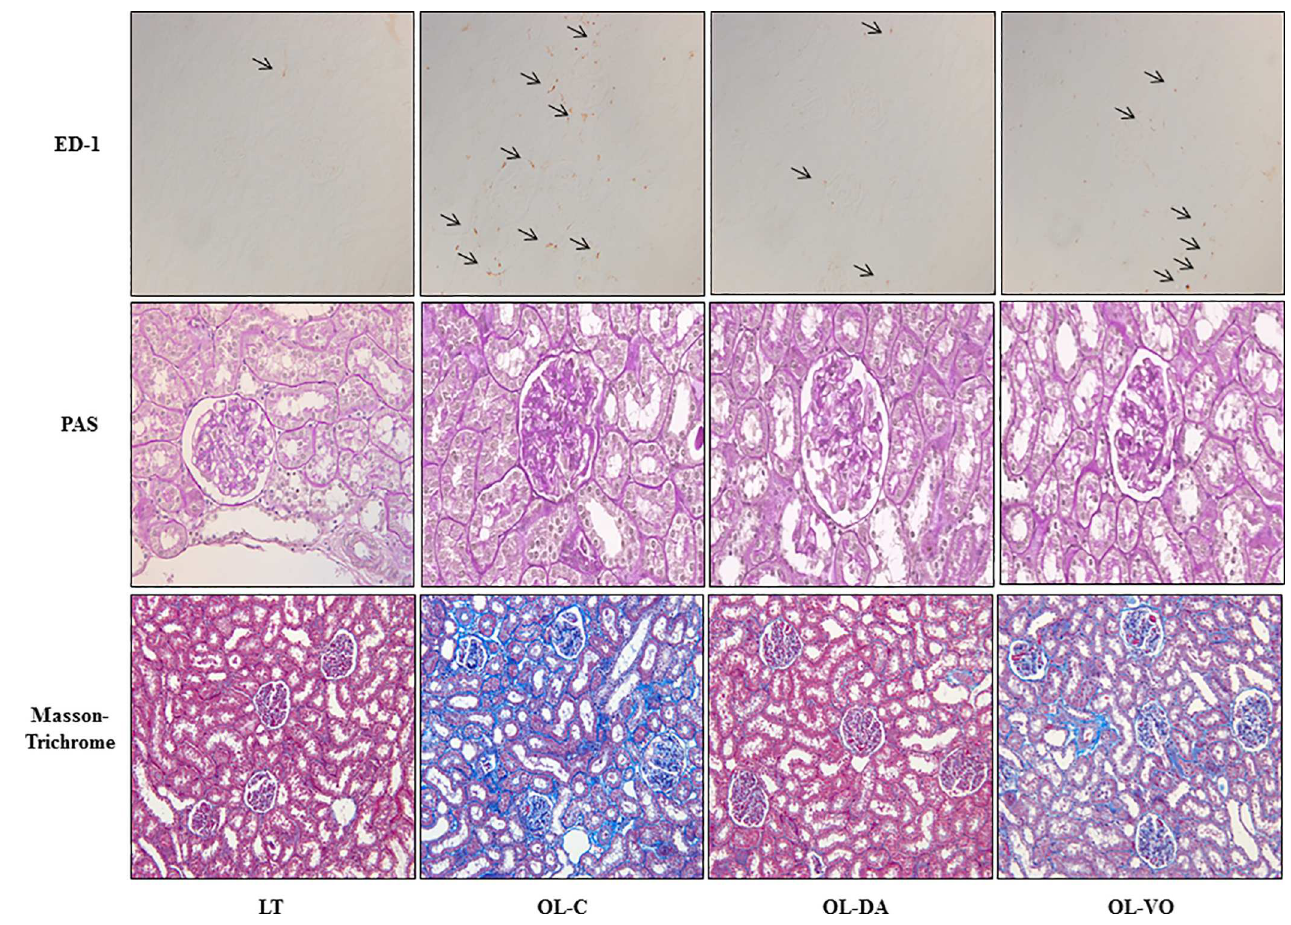
Fig 6. Changes in glomerular or tubulointerstitial phenotypes in LETO or OLETF rats. Representative sections for assessing the inflammatory cell infiltration (immunostaining for ED-1, x 200), glomerularexpansion(PAS, x 400) and tubulointerstitial fibrosis (Masson trichrome, x 200) in LETO (LT) and OLETF rats with saline (OL-C), dapagliflozine (OL-DA) or voglibose (OL-VO)